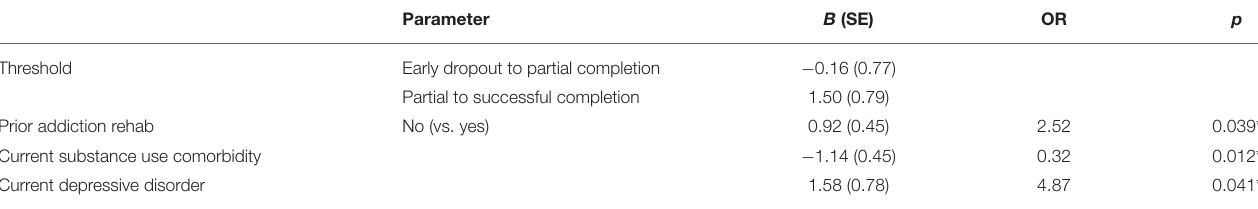
TABLE 2 | Ordinal logistic regression model.